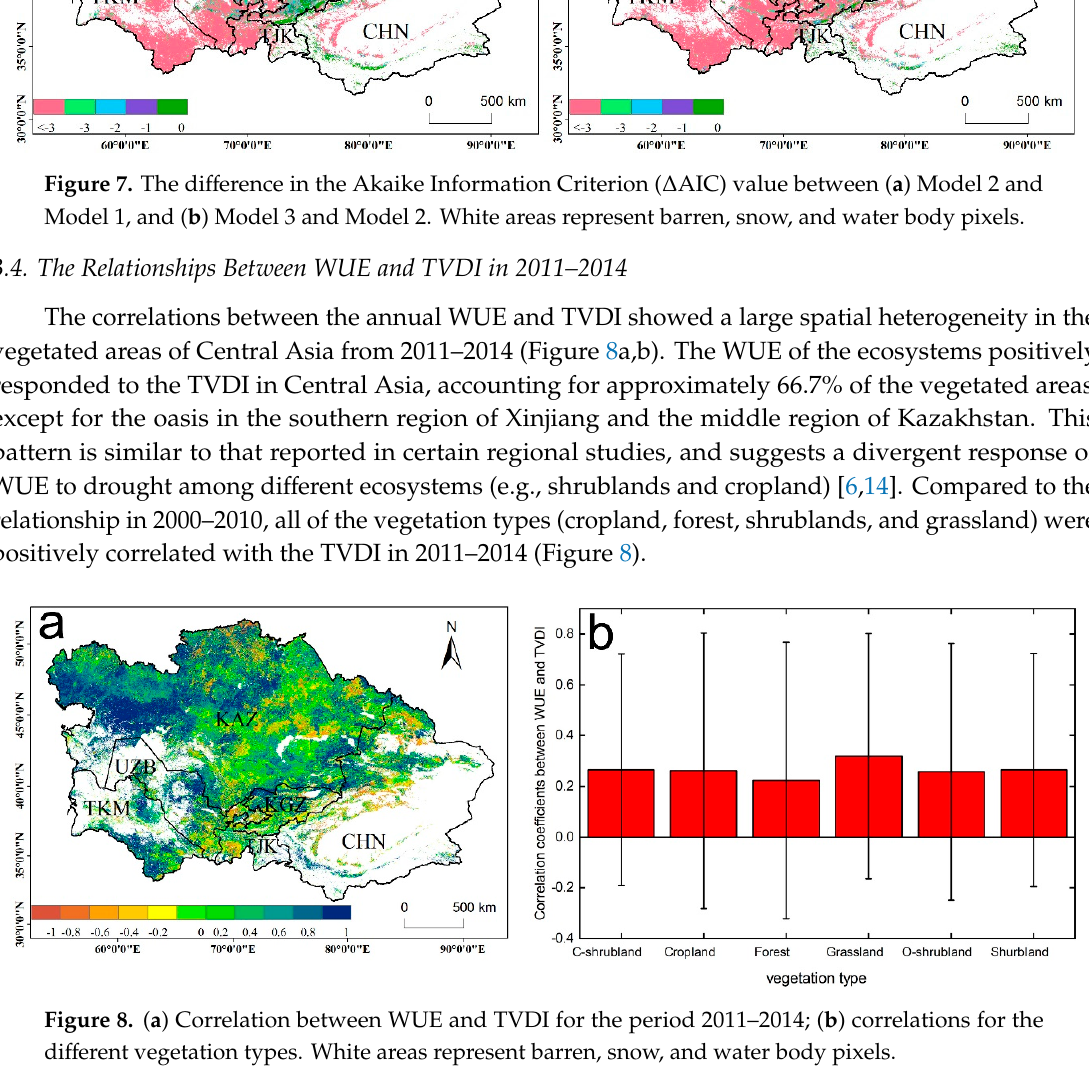
Figure 6. Different model R 2 values between ( a ) previous one year and the current year, and ( b ) previous two years and previous one year. White areas represent barren, snow, and water body pixels.